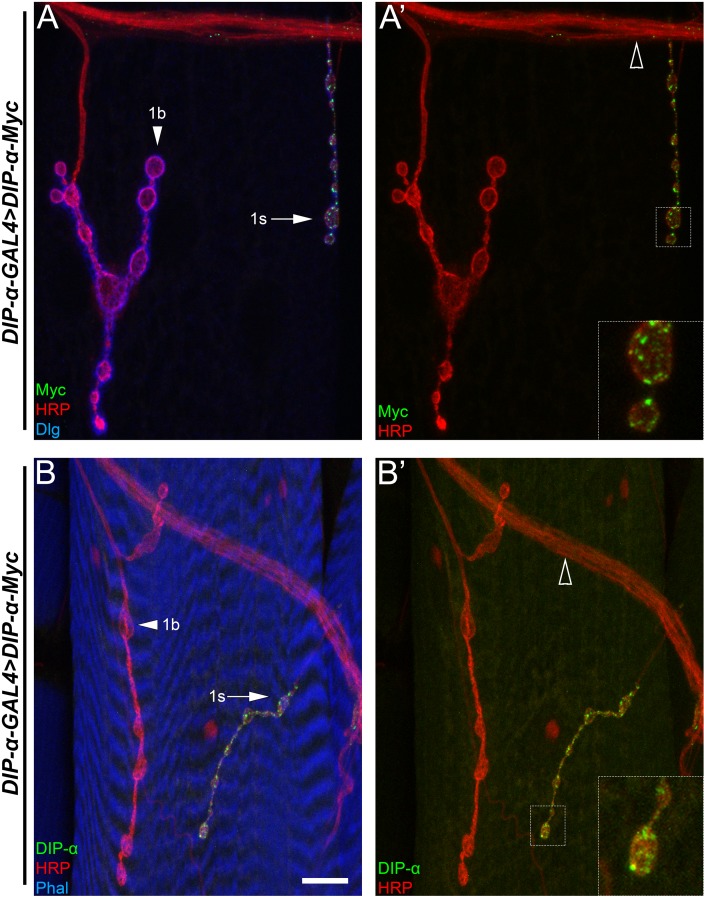
DIP-α protein from a transgene localizes normally in rescue animals.(A,B) The DIP-α rescue construct, tagged with a c-terminal Myc tag, labeled with (A) anti-Myc (green), anti-HRP (red) and anti-Dlg (blue) or (B) anti-DIP-α (green), anti-HRP (red) or phalloidin (blue). Note localization only to 1s boutons (arrows) and not 1b boutons (arrowheads). Open arrowheads denote the ISN. Calibration bar is 10.5 µm. See also Figure 2.